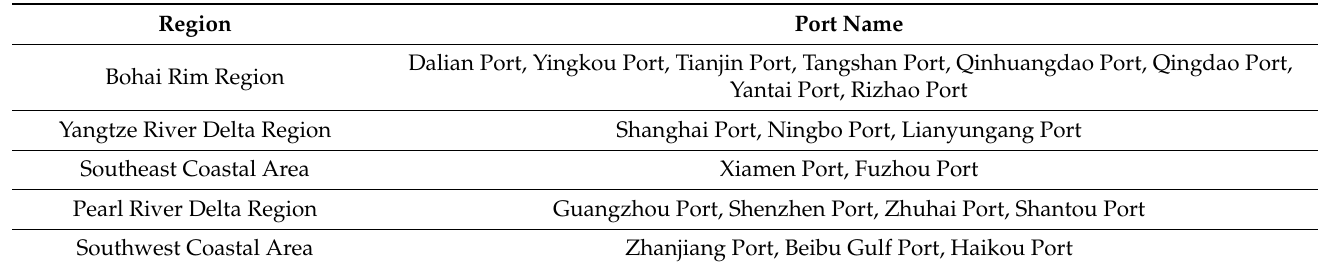
Table 1. Chinese ports and their